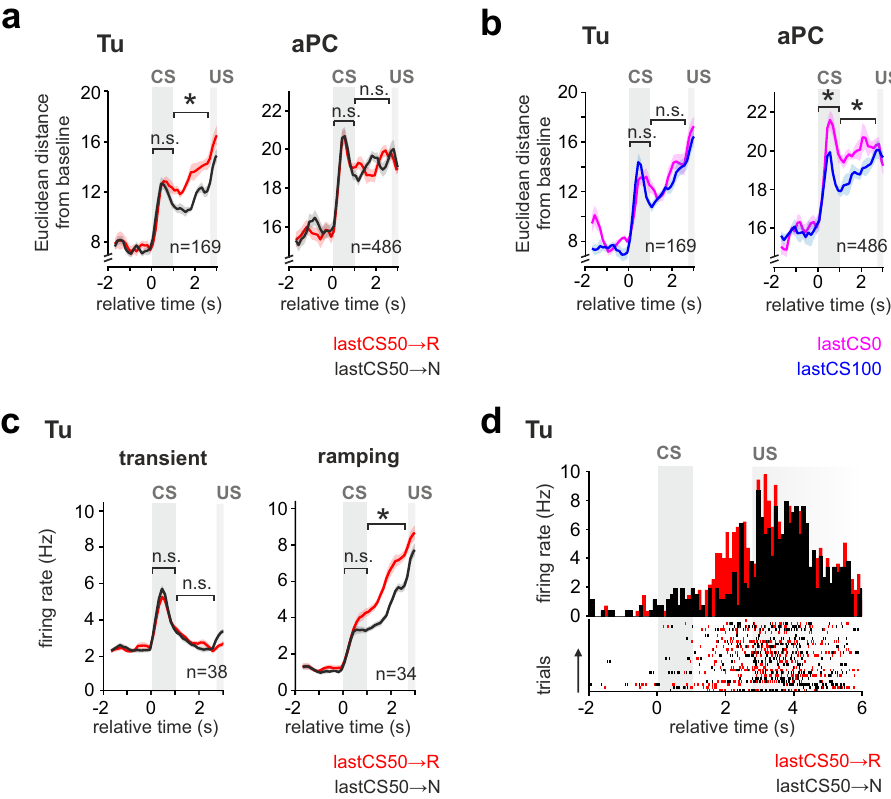
Fig. 10 Updating of the reward prediction coding through the recent cue-speci fi c outcome history. a Mean Euclidean distance from baseline ± SEM of the population vector during the lastCS50 → R and lastCS50 → N trials. If the previous CS50 trial had been rewarded, Tu population displayed a stronger response than if it had been unrewarded (left). In contrast, no recent outcome-history effect was observed in the aPC population (right). b Same as ( a ) but dividing CS50 trials based on whether the prior trial was CS100 or CS0. Satiety did not change the population response of Tu at CS and during wait (left), but reduced the population responses of aPC (right). One-way ANOVA on Tu history and satiety combined (left graph) during: CS, F (3,28) = 0.3, P = 0.8; wait, F (3,28) = 10.9, P = 6.4 e-5; Tukey post hoc, P (history) = 7.1 e-5, P (satiety) = 0.4. One-way ANOVA on aPC history and satiety (right graph) during: CS, F (3,28) = 8.4, P = 3.7 e-4; Tukey post hoc, P (history) = 0.6, P (satiety) = 3.1 e-4; wait, F (3,28) = 4.4, P = 1.2 e-2, P (history) = 0.5 P (satiety) = 0.01. c Mean fi ring rate ± SEM during lastCS50 → R and lastCS50 → N trials for the transient- and ramping clusters of Tu. The ramping clusters encoded outcome history during the waiting interval, while the transient cluster showed no effect. One-way ANOVA on history and satiety (see Supplementary Fig. 10b, c) of the transient cluster (left graph): CS, F (1.2,44.1) = 0.2, P = 0.7; wait, F (1.6,59.7) = 0.9, P = 0.4. One-way ANOVA on history and satiety (see Supplementary Fig. 10b, c) of the ramping cluster (right graph): CS, F(1.9,62.1) = 16.9, P = 2.0 e-6; Tukey post hoc, P (history) = 0.2, P (satiety) = 1.8 e-4; wait, F (2.3,75.3) = 20.9, P = 1.4 e-8, Tukey post hoc, P (history) = 2.7 e-7, P (satiety) = 0.02. See Supplementary Fig. 10b – e for a systematic analysis of outcome history and satiety in all response clusters of Tu and aPC. d PSTH and raster plot of an example Tu unit from the ramping-cluster coding for outcome history. In the fi gure: * indicates P < 0.05, n indicates the number of